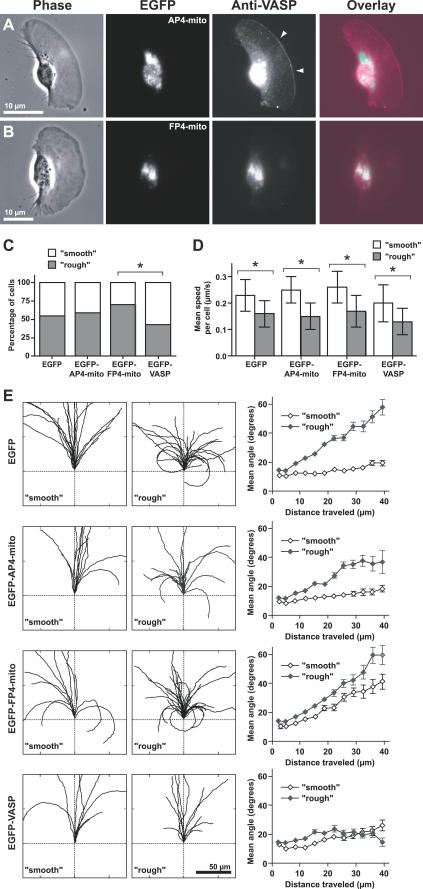
Ena/VASP Mislocalization Decreases the Prevalence of Fast, Persistent-Moving Smooth Cells(A) EGFP-AP4-mito (negative control) binds to mitochondria in the cell body, but does not mislocalize VASP, which, by immunofluorescence, appears as a thin line at the leading edge of cells with a smooth morphology (arrowheads).(B) EGFP-FP4-mito mislocalizes VASP at the surface of mitochondria thus preventing its function at the leading edge. Weak VASP localization was only observed at the leading edge in two cells out of more than 50 cells examined. Scale bar = 10 μm.(C) Keratocytes were classified as either having a smooth or rough leading edge within populations of migrating keratocytes expressing the aforementioned EGFP-tagged constructs. Cells with a rough leading-edge morphology are more prevalent than those classified as having a smooth morphology when EGFP-FP4-mito is expressed (70%) compared with controls, EGFP (55%) and EGFP-AP4-mito (59%). The incidence of rough keratocytes is significantly lower (43%) when EGFP-VASP is overexpressed (when compared to EGFP-FP4-mito, p < 0.05).(D) Keratocytes exhibiting smooth leading edges are significantly faster than those with rough leading-edge morphology (EGFP, p = 0.0002; EGFP-AP4-mito, p = 0.0004; EGFP-FP4-mito, p = 0.0004; EGFP-VASP, p = 0.0065). Mean and SD are plotted.(E) To perform qualitative comparisons of keratocyte turning during migration, trajectories of smooth or rough keratocytes were reoriented to start at x,y = 0 in the +y direction in standardized coordinate systems (left and middle panels). Trajectories were truncated (x,y limits = 150 μm) for illustration purposes. The distance between tick marks is 50 μm. For quantitative comparisons, mean angles between velocity vectors separated by specific distances traveled by cells were plotted. Larger mean angles correspond to increased curvature in the trajectories of migrating cells (right panels). Mean angles are significantly smaller for smooth keratocytes expressing negative control constructs compared to rough cells (EGFP, p = 0.0003; EGFP-AP4-mito, p = 0.001), showing that smooth keratocytes maintained straighter paths than rough ones. Ena/VASP protein mislocalization using EGFP-FP4-mito causes smooth cells to move in more curved trajectories with larger mean angles not significantly different from those of rough cells and significantly different from those of smooth cells expressing control constructs (compared to EGFP smooth, p = 0.01; EGFP-AP4-mito smooth, p = 0.005). On the other hand, when keratocytes overexpress EGFP-VASP, rough keratocytes, which have increased trajectory curvature in controls, have straighter paths with smaller angles similar to those from smooth cells expressing controls and EGFP-VASP. Mean and SEM are plotted.